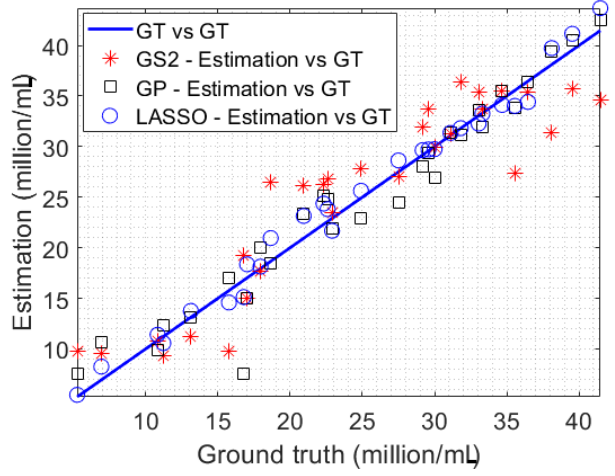
Figure 10. The microalgal density estimation results versus the ground truth in the testing data.